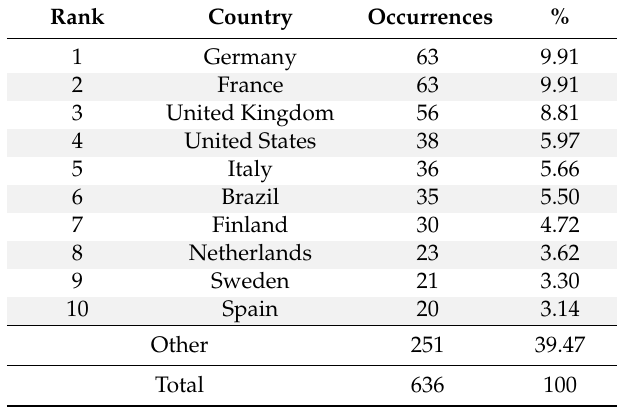
Table 7. Occurrences of most productive countries in the scope of competence-based management.